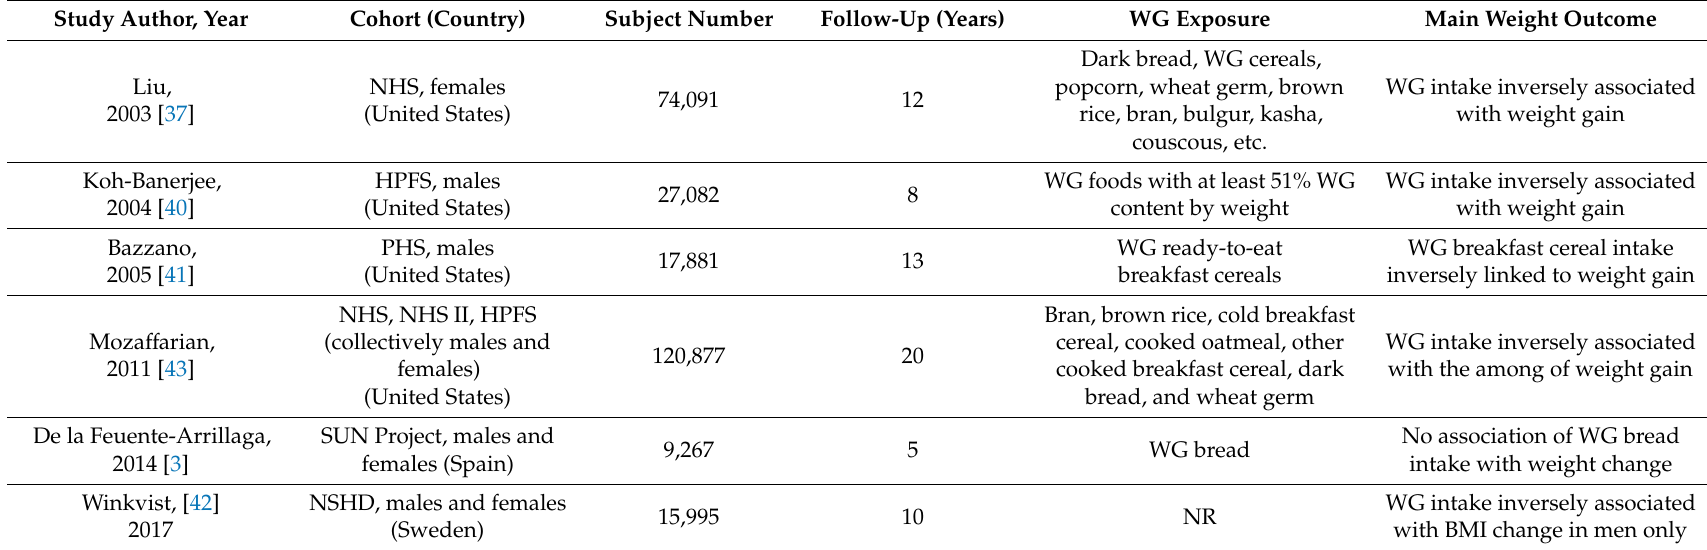
Table 1. Outcomes summary of 6 cohort studies assessing the prospective association between WG intake and weight change 1